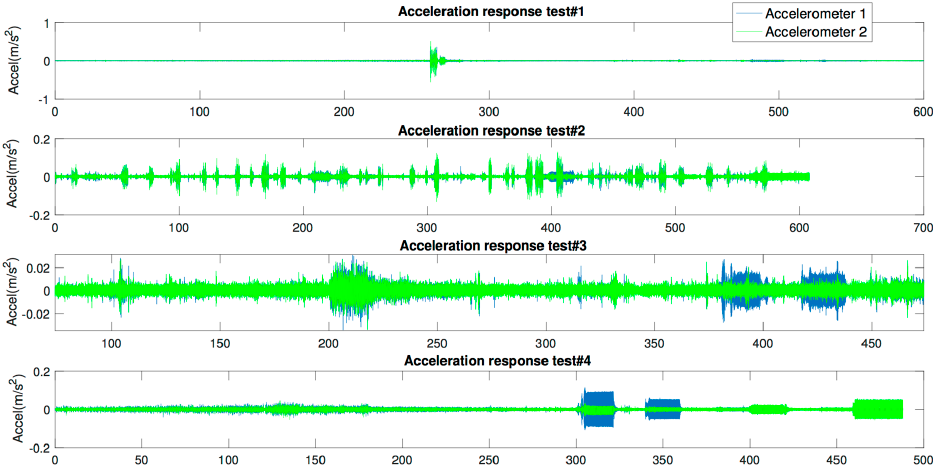
Figure 8. Portal frame under vibration test.